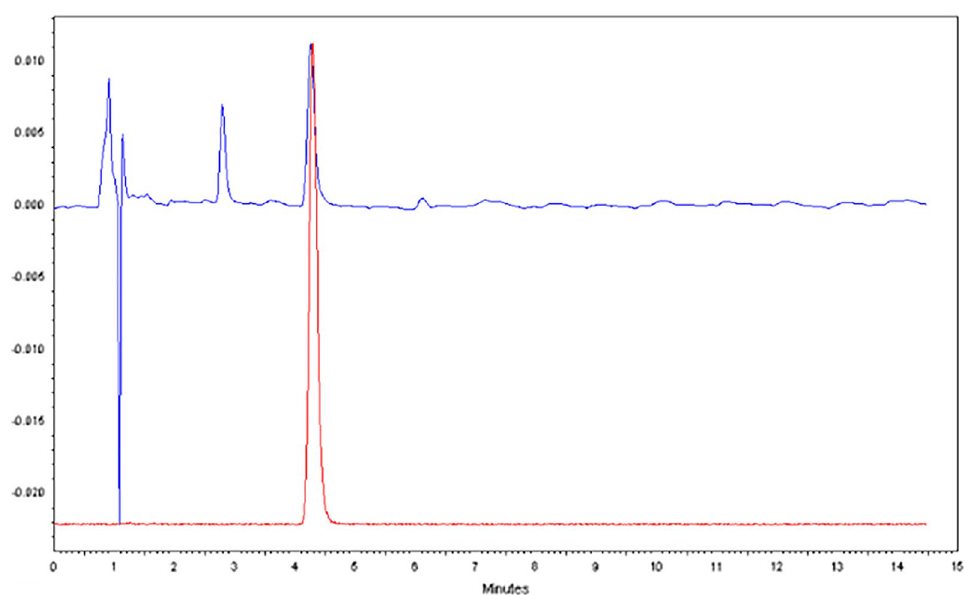
Figure 3. Analytical radio-HPLC of [ 18 F]TsF, analyzed 12 h later after generation of [ 18 F]TsF (Red: UV; Blue: radioactivity). The peak at 3 min is from TsCl and TsCl at 5.5 min was not